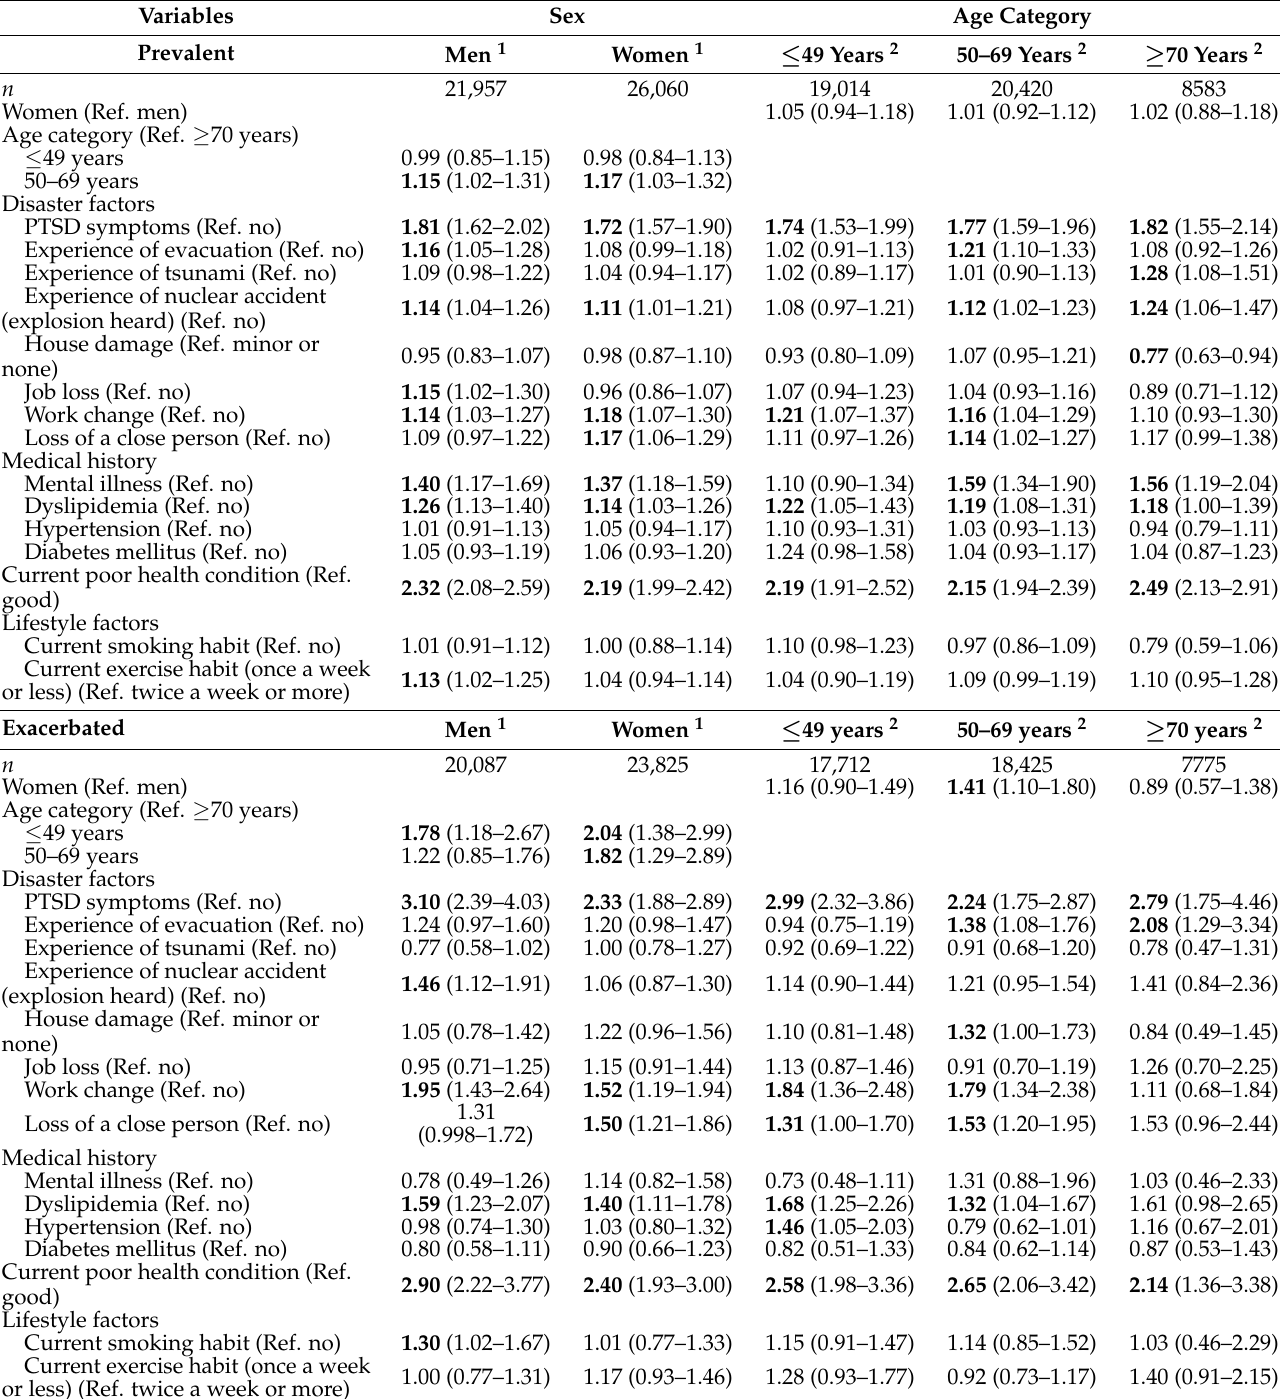
Table 3. Multiple adjusted odds ratios and 95% CI for prevalent and for exacerbated oral symptoms by sex and age